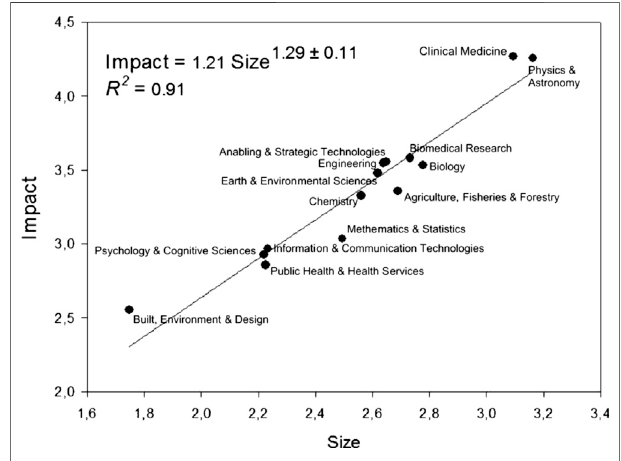
FIGURE 3 | Power-law correlation of impact on